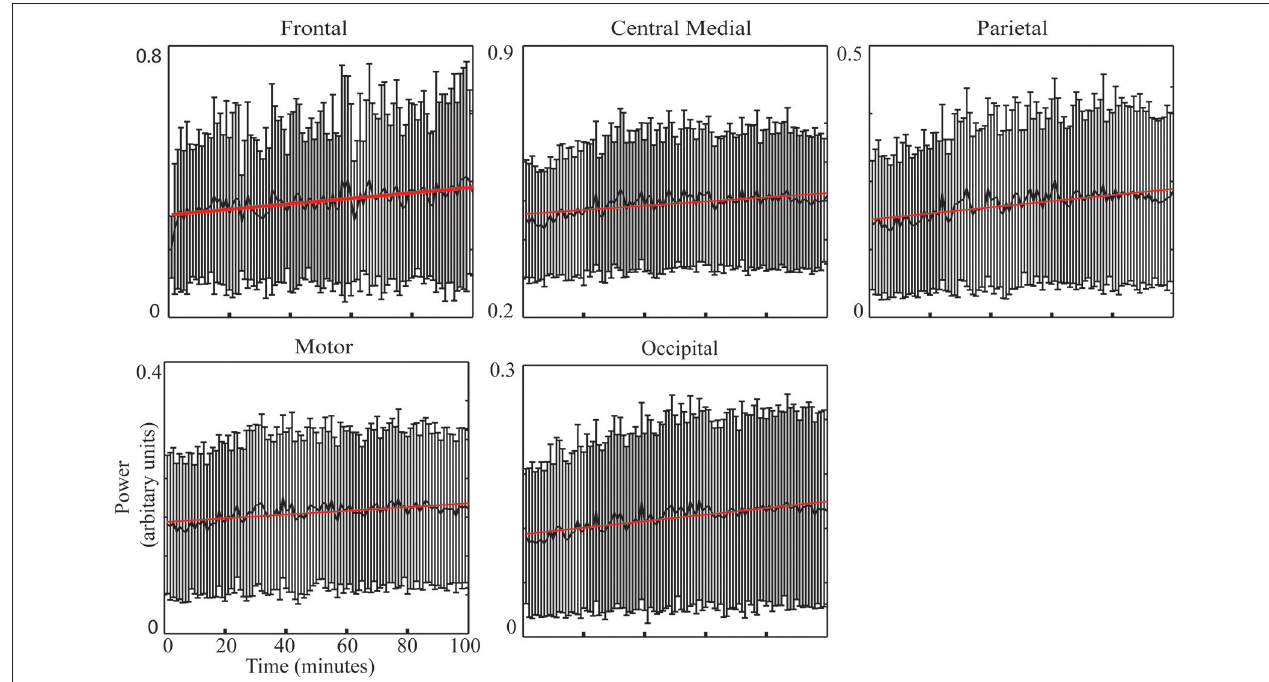
FIGURE 3 | IC spectral powers across 100 min (thick black curve: mean) across all sessions with the linearly regressed lines (red line).